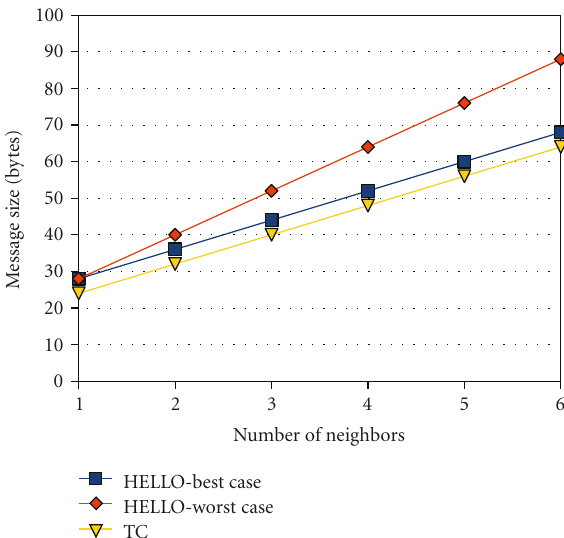
Figure 9: HELLO and TC message sizes when varying the number of neighbors.